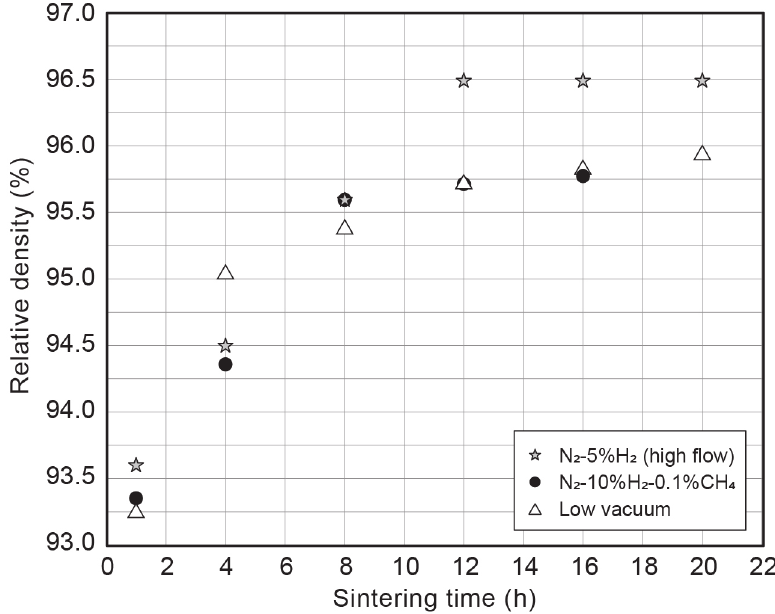
Figure 8. Relative density as a function of sintering time at 1325 °C under different sinter- ing